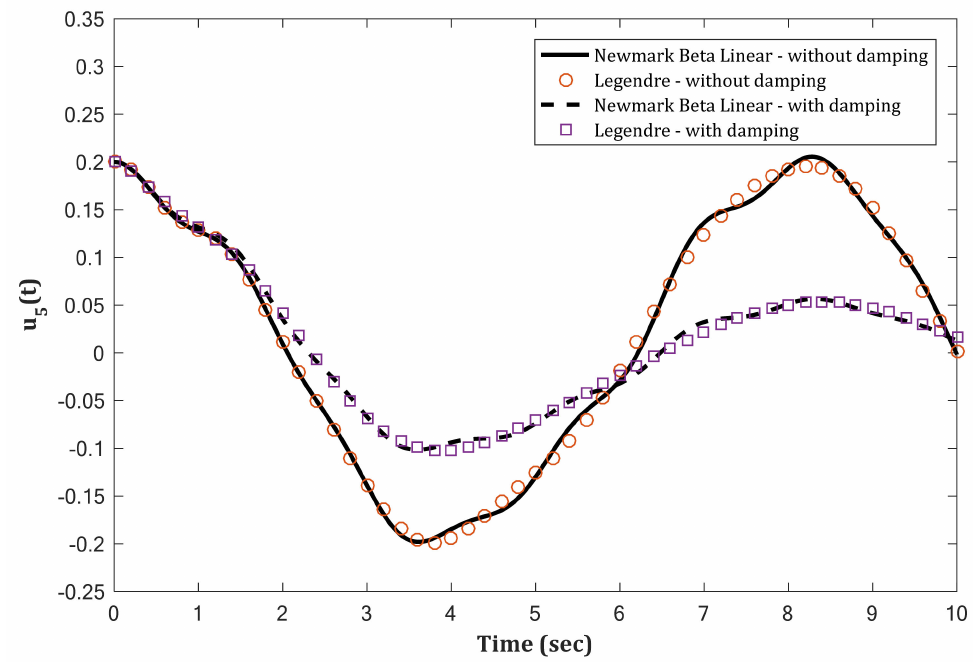
Figure 17. Free vibration analysis of a 5DOF system. Comparison of u 5 ( t ) as a function of time, as obtained using the LGM method or the linear Newmark- β